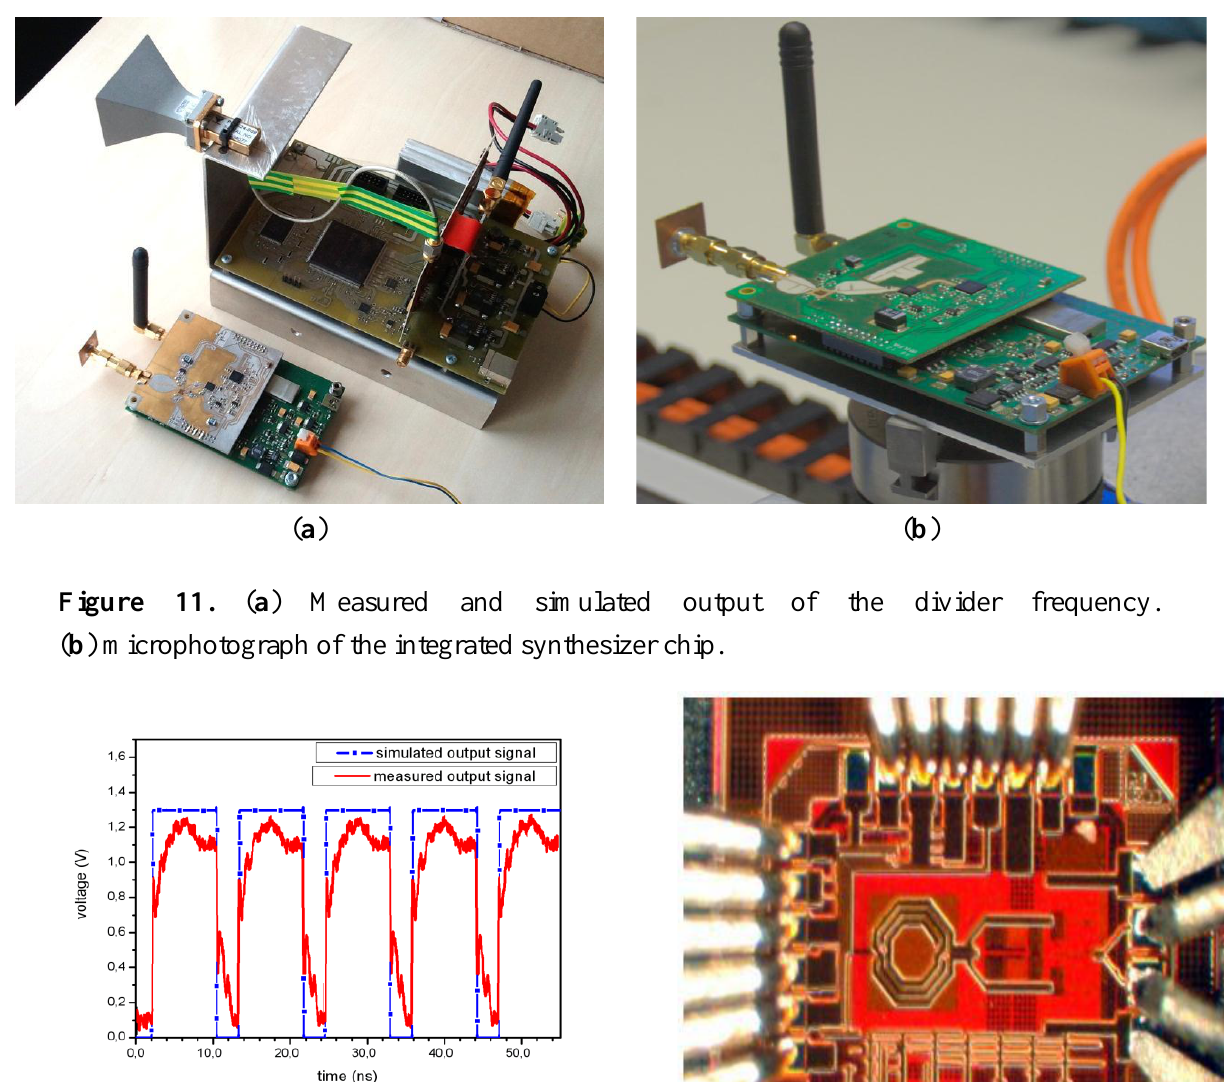
Figure 10. ( a ) Sensor of the first and second generation. ( b ) Measurement system.